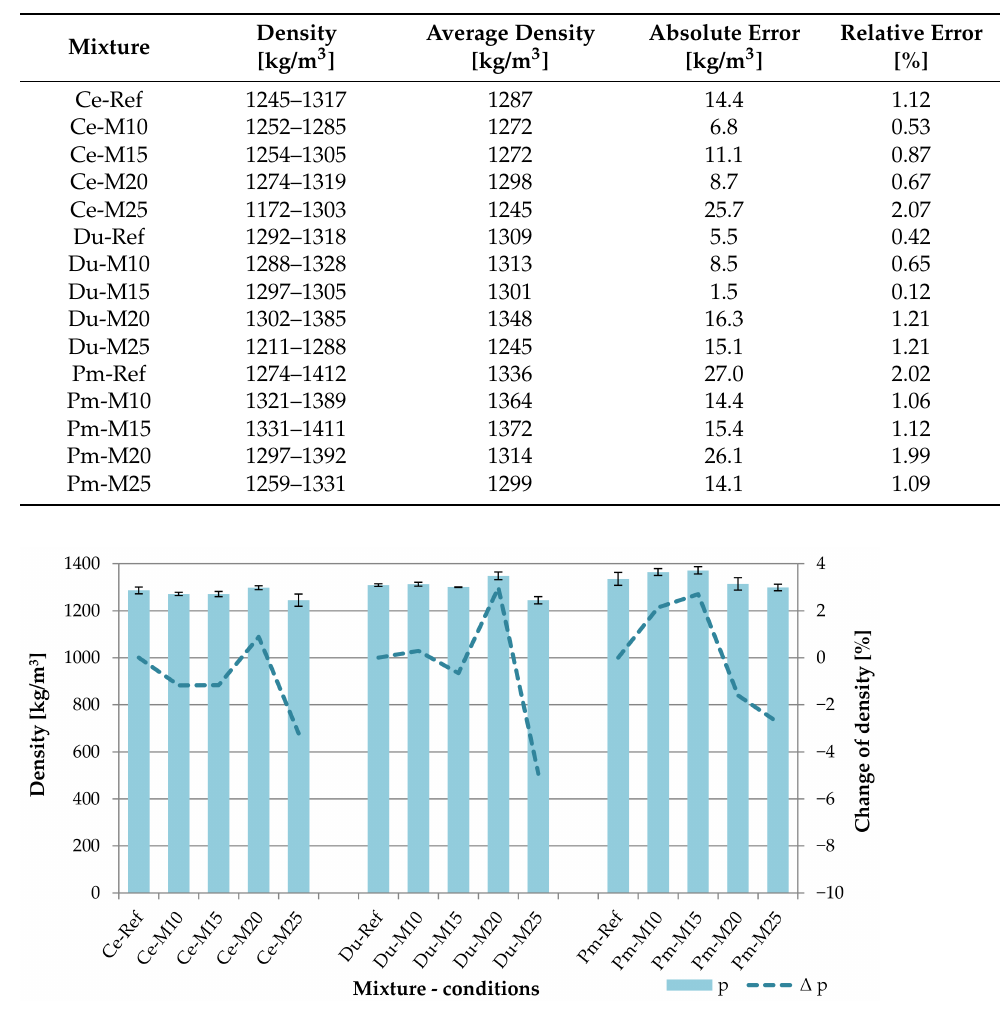
Figure 12. Comparison of density of tested boards; columns—density (p), curves—change of density ( ∆